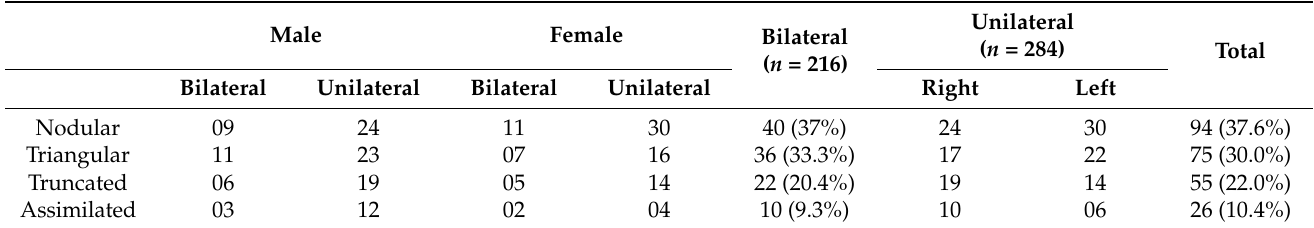
Table 1. Distribution and incidence (in parentheses) of the lingula in males and